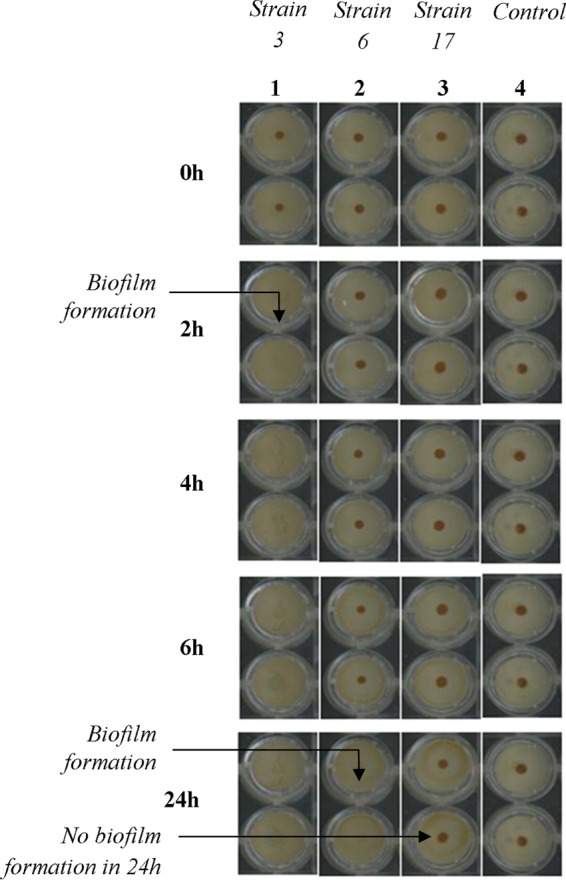
Kinetics of biofilm formation by three selected P. aeruginosa strains with the BioFilm Ring Test at different incubation times. Strip 4, controls with BHI medium and toner alone. Well images were obtained by scan of microplates with the plate reader after magnetization by the block test.